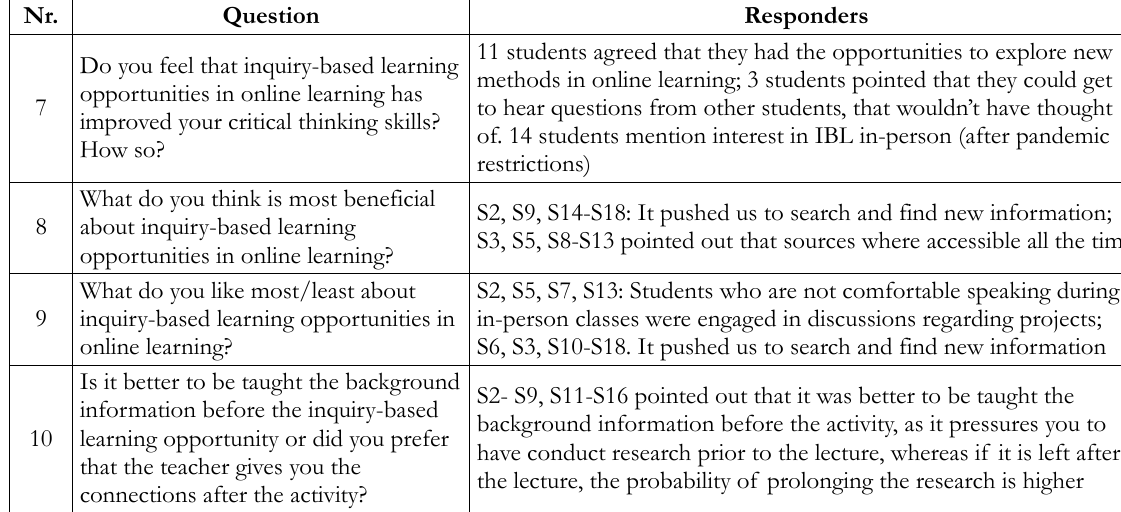
Table 6. IBL impact on student